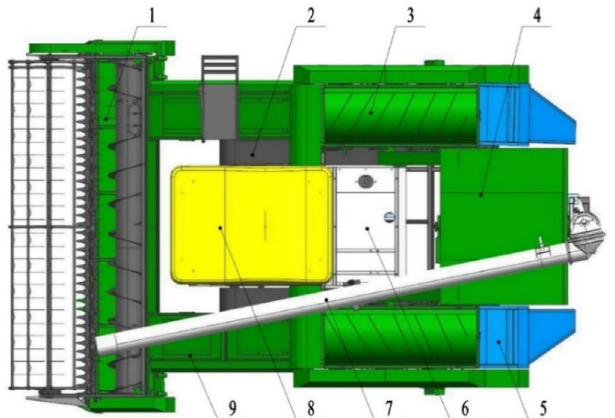
Figure 1. Double-channel feeding ratoon rice harvester. ( 1 ) double-channel header, ( 2 ) track, ( 3 ) threshing and cleaning device, ( 4 ) grain bin, ( 5 ) smashing and scattering device, ( 6 ) engine, ( 7 ) grain unloading device, ( 8 ) sunshade, ( 9 ) conveying channel. (SolidWorks 2020, https:// www. solid works. com/ zh-